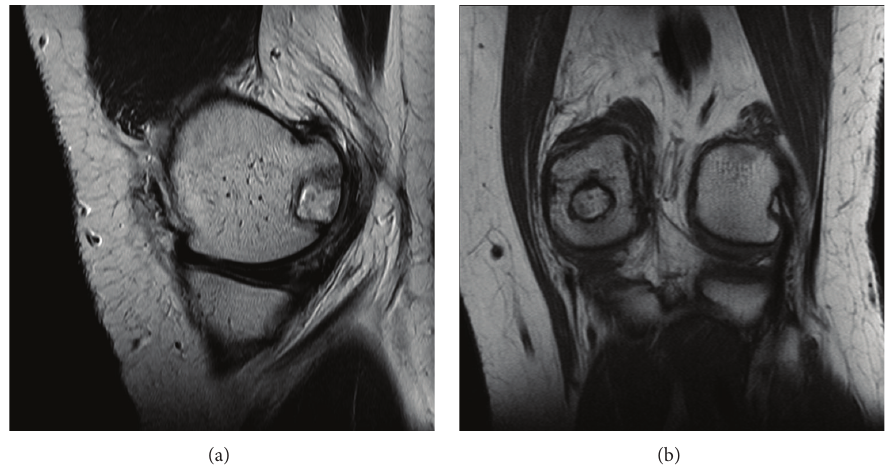
Figure 7: One-year postoperative PD TSE sagittal (a) and T1 TSE coronal (b) images showing osteochondral allograft incorporation and congruency of chondral surface. No evidence of local